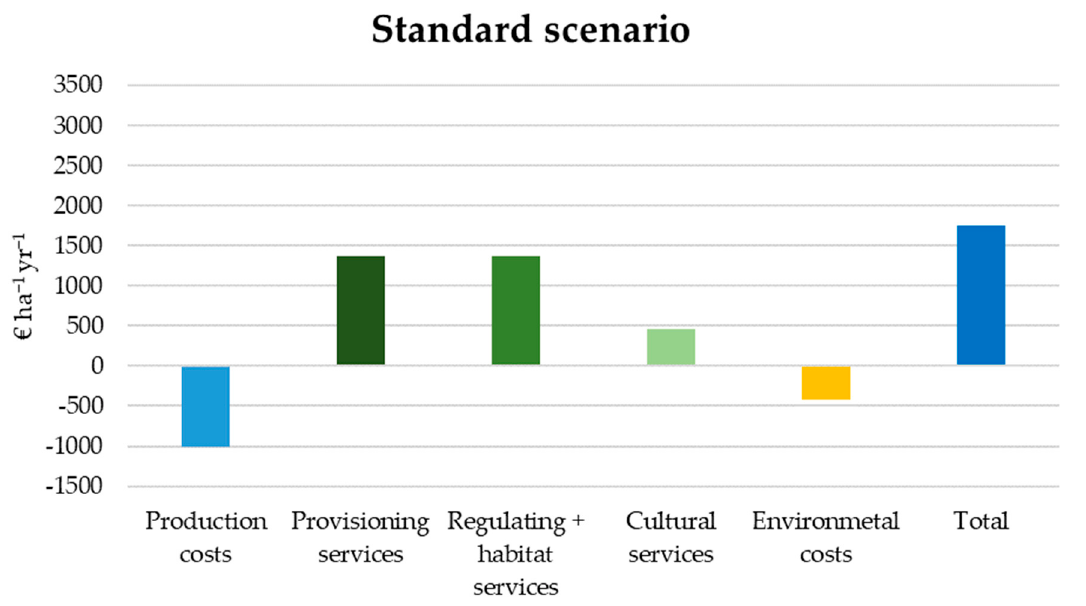
Figure 2. True costs and benefits in the standard scenario, assuming average ESs provision and central monetization factors for environmental